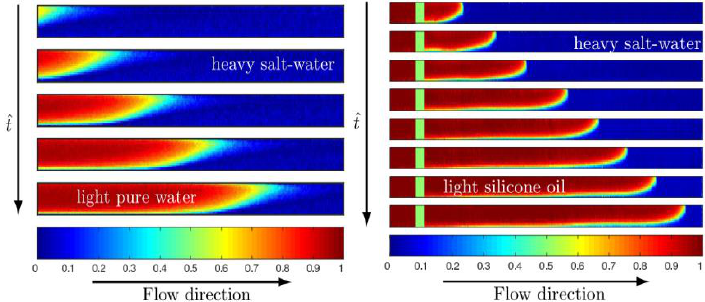
Figure 5. The left side (mutually-dissolved fluids): the flow characteristics of light silicone oil displacing heavy salt-water with time; The right side (immiscible liquids): the flow characteristics of light pure water displacing heavy salt-water with time [10].